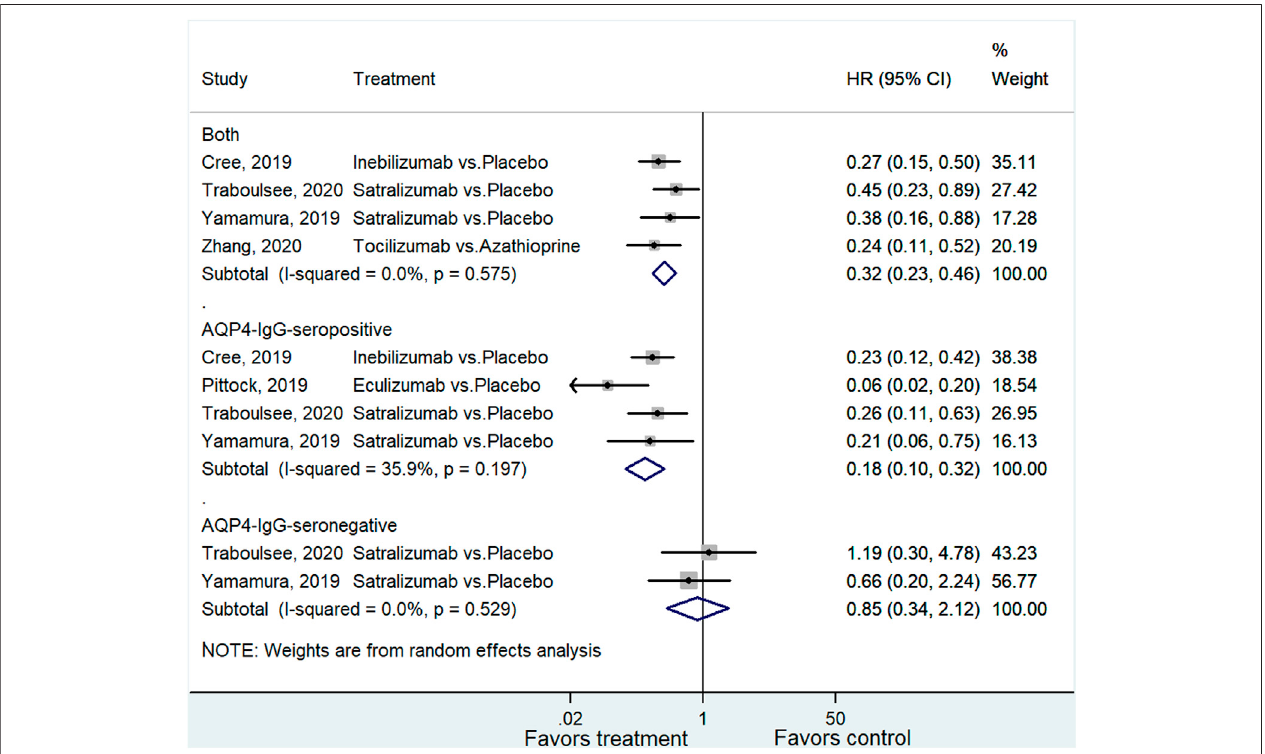
FIGURE 2 | Forest plot of HR for relapse in all NMOSD, AQP4-IgG-seropositive NMOSD, and AQP4-IgG-seronegative NMOSD patients.